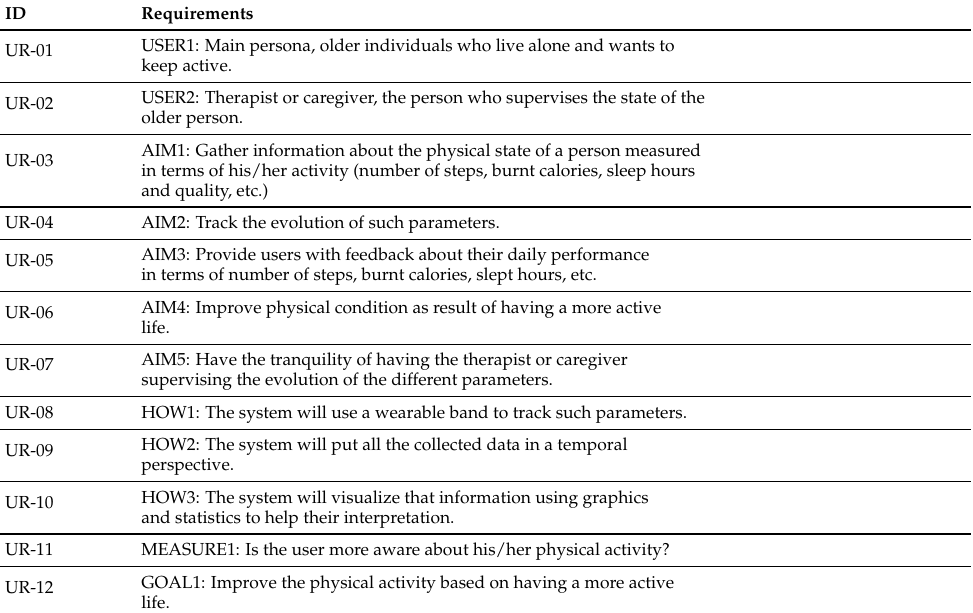
Table 5. User Requirements for physical activity monitoring with wearable